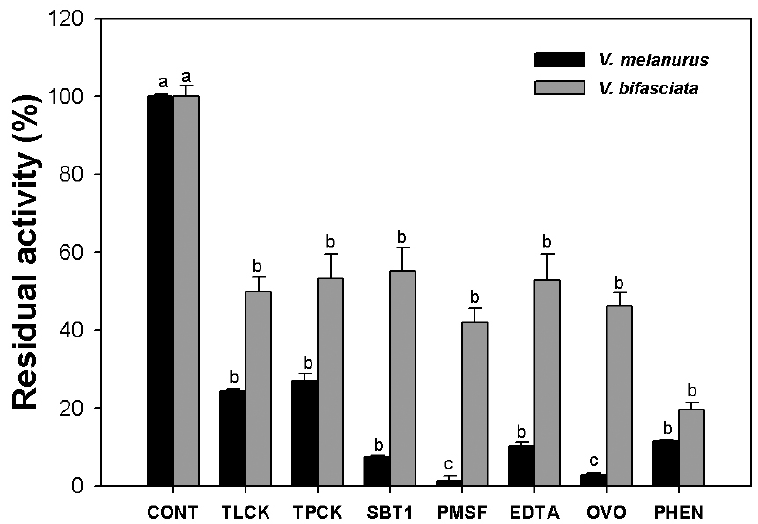
FIGURE 5 | Effect of inhibitors on alkaline digestive proteases of Vieja melanurus and V. bifasciata : Alkaline control (alkaline proteases without inhibitor), TPCK (N-p-Tosyl-L-phenylalanine chloromethyl ketone), PHEN (phenanthroline), EDTA (ethylenediaminetetraacetic acid), TLCK (Tosyl- L-lysyl-chloromethane hydrochloride), OVO (ovalbumin), SBT1 (soybean trypsin inhibitor), PMSF (phenylmethylsulfonyl fluoride) (mean ± SD, n = 3) significant differences (P< 0.05) between inhibitors values are shown by letters. Different letter between bars indicates statistical